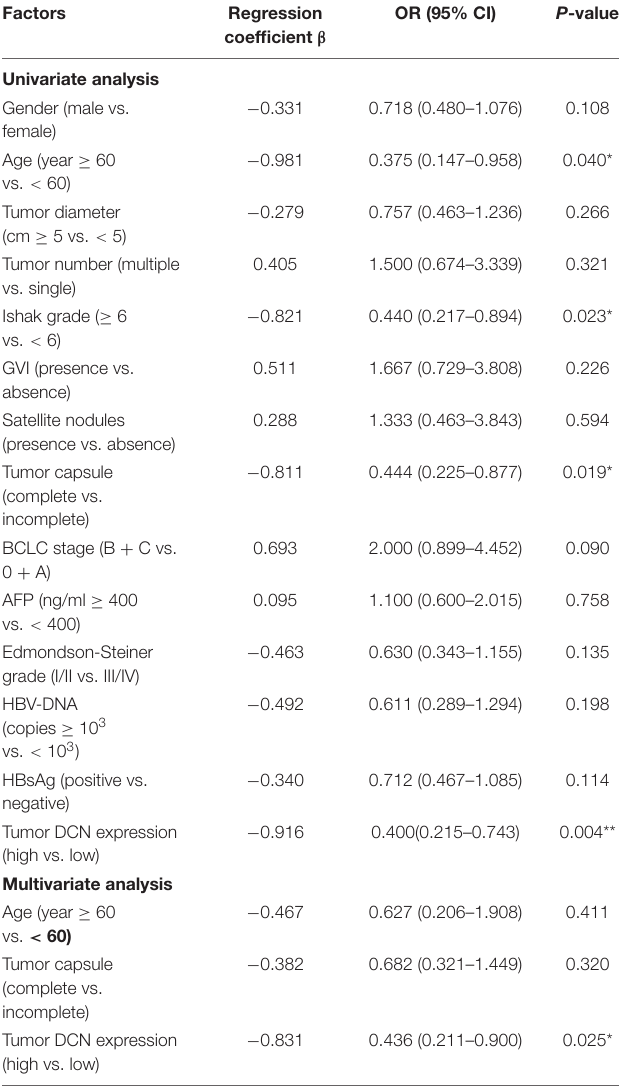
TABLE 3 | Univariate and multivariate analysis of risk factors of